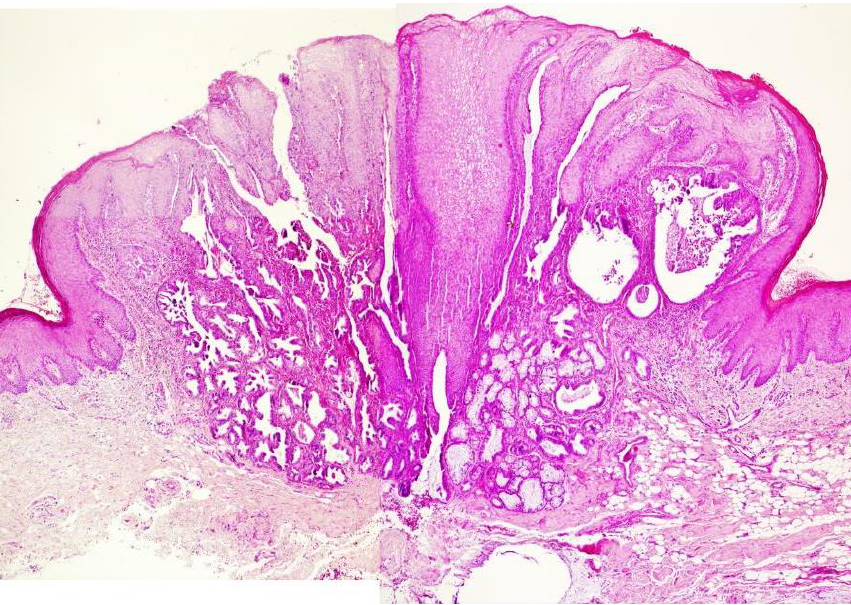
Figure 2. Example of histological features of SP (case different from that presented in Figure 1): exophytic papillary structure covered by stratified squamous epithelium and glandular structures below the mucosa (H&E — 50X).